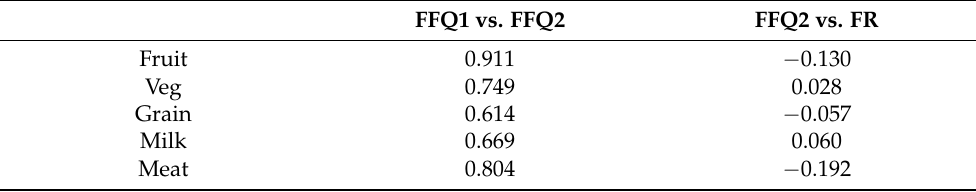
Table 6. Pearson correlation coefficients of food groups intake between two FFQ, 24 h recall. FFQ1 vs. FFQ2 FFQ2 vs. FR Fruit